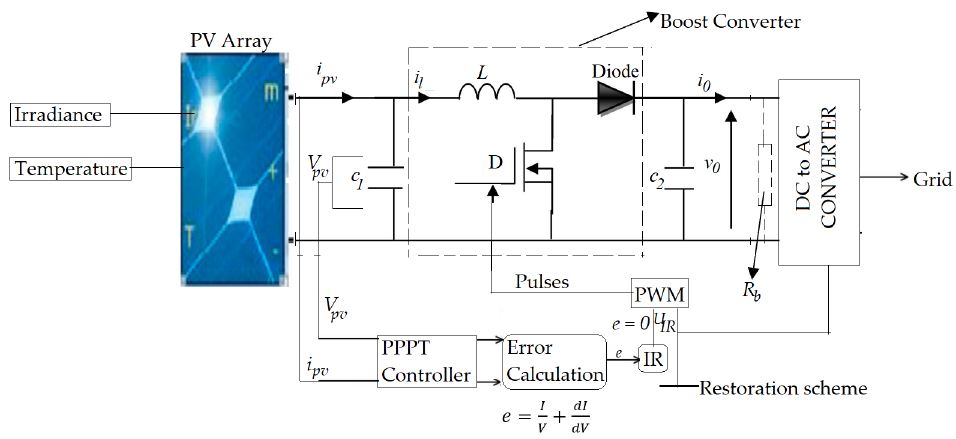
Figure 5. Proposed boost converter and the IC + IR PPPT technique.